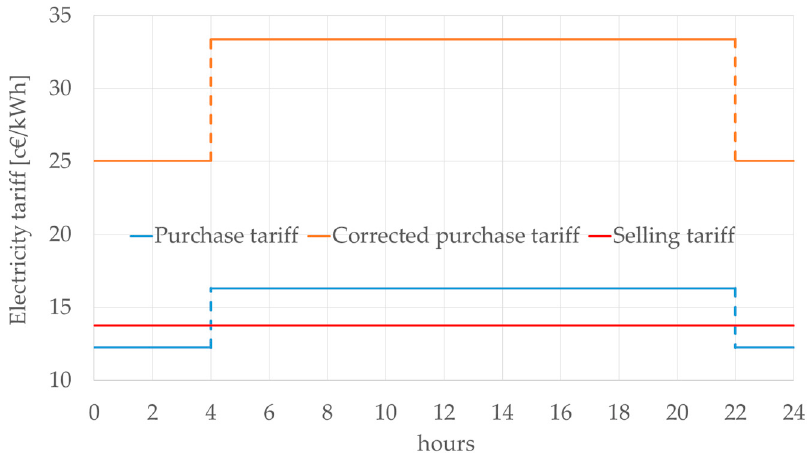
ff s over a day.